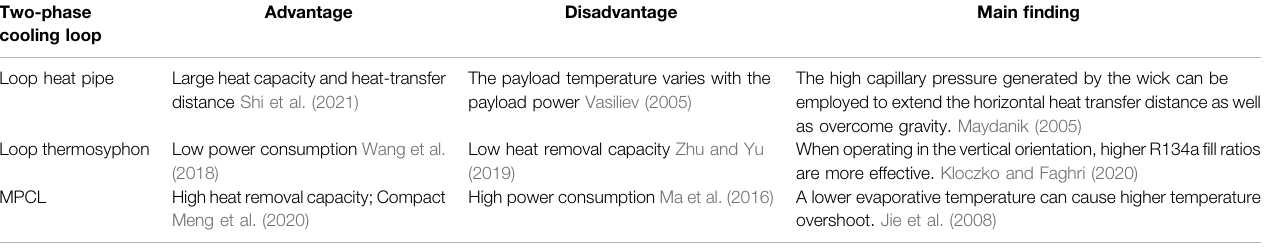
TABLE 1 | Summary of two-phase cooling loop research.